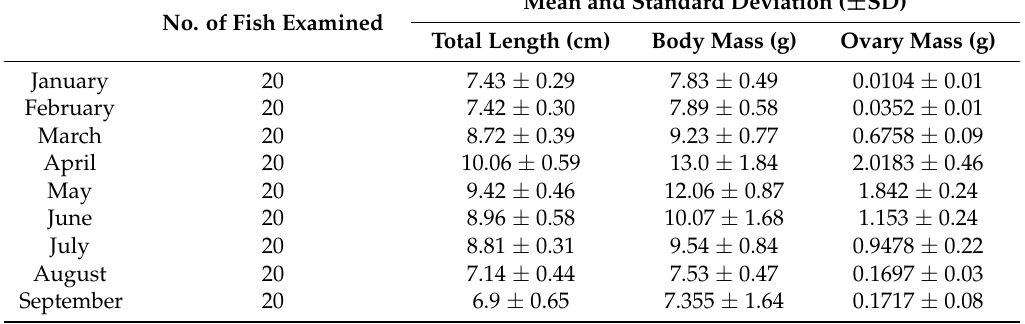
Table 1. Mean and standard deviation ( ± SD) of total length, body mass, and ovary mass in female P. sophore in